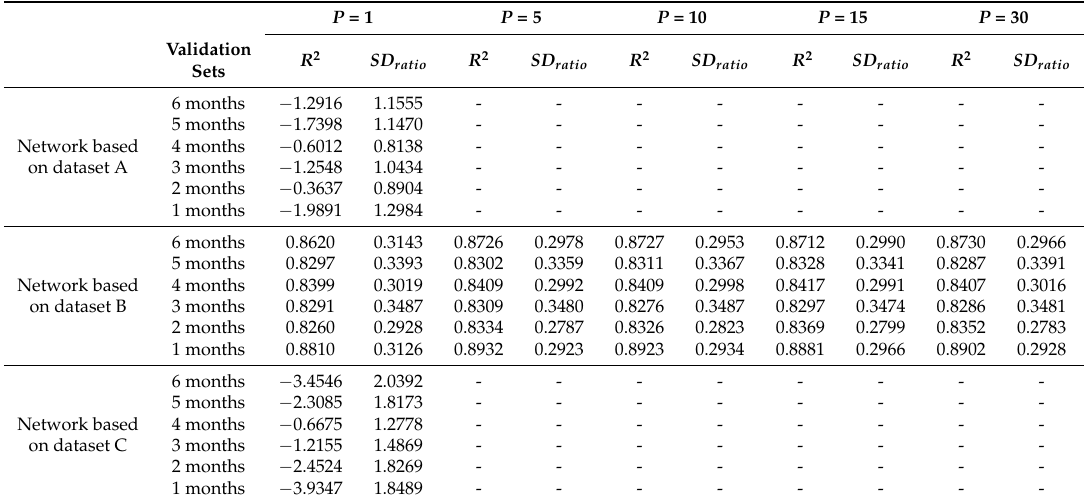
Table 12. Performance Indices for validation—dynamical content